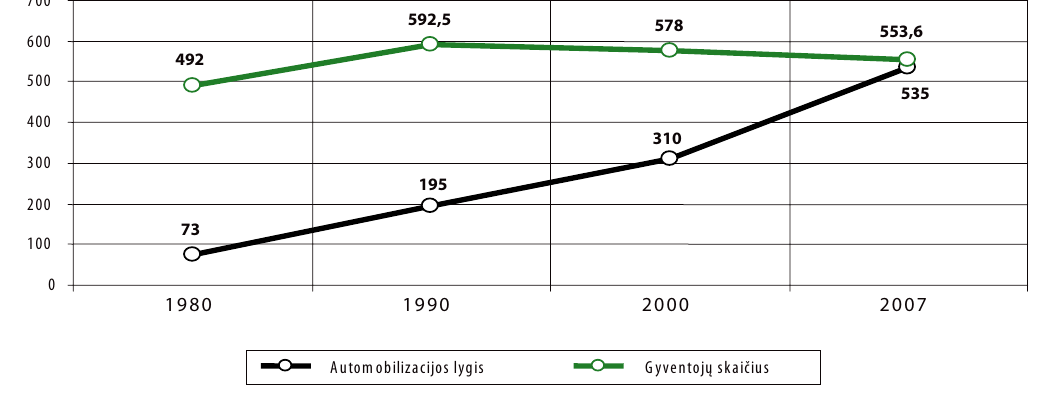
Fig. 2. Change dynamic of inhabitant number and motorization level in